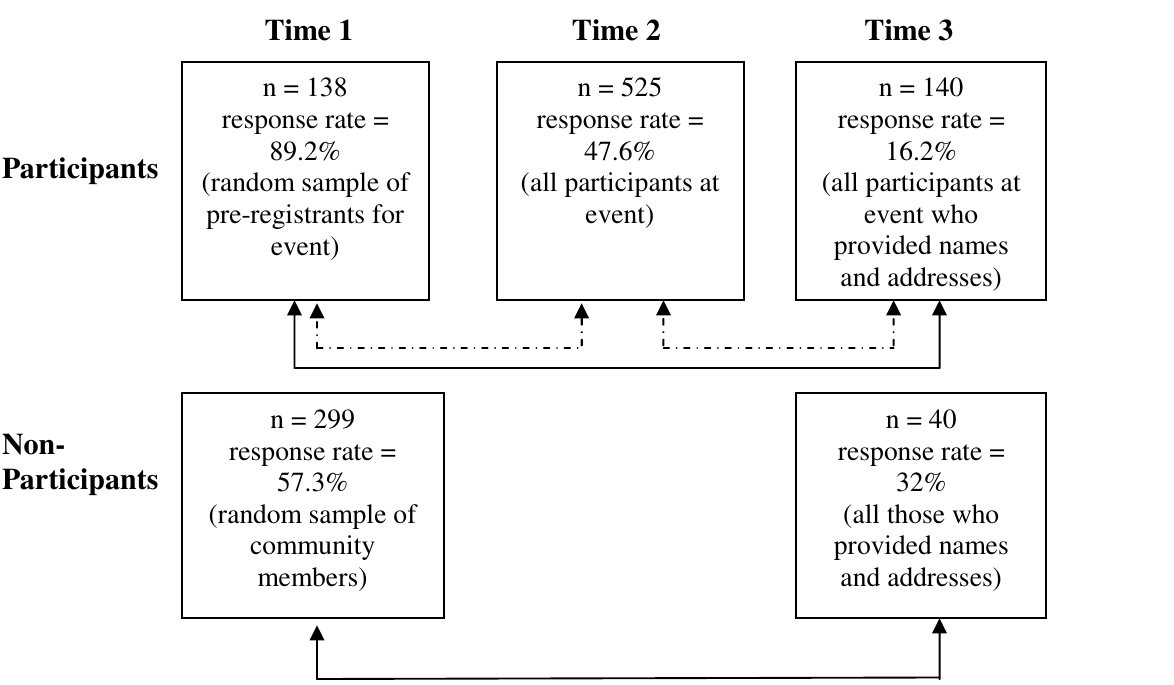
Figure 1: Subjects and Response Rates for Data